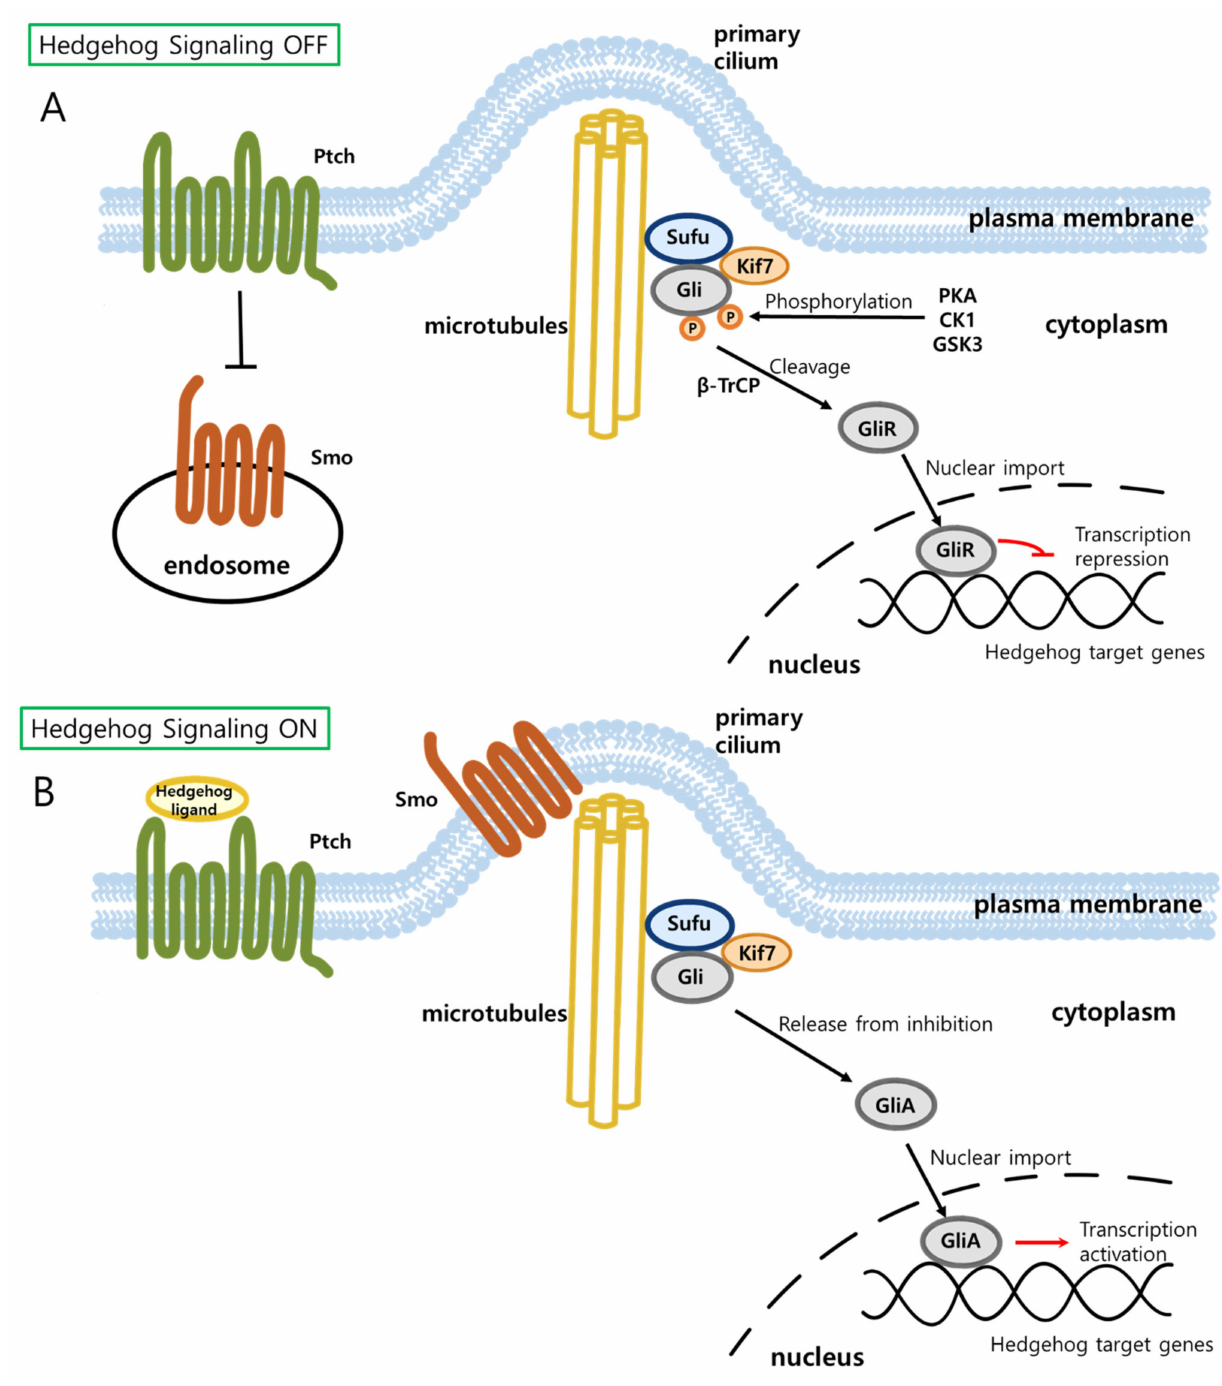
Figure 2. Schematic illustration of signal transduction by the canonical Hedgehog signaling pathway. ( A ) In the absence of the ligand, the patched receptor (Ptch) suppresses Smo, leading to the generation of Gli repressor (GliR) by proteolytic cleavage of Gli. GliR suppresses transcription of Hedgehog target genes. ( B ) Binding of ligands to Ptch relieves the suppression of Smo by the receptor, leading to move- ment of Smo to primary cilium where it inhibits proteolysis of Gli. Uncleaved and unphosphorylated Gli protein translocates into the nucleus and induces transcription of Hedgehog target genes as Gli transcriptional activator (GliA). Ptch, Patched; Smo, Smoothened; Gli, Glioma-associated